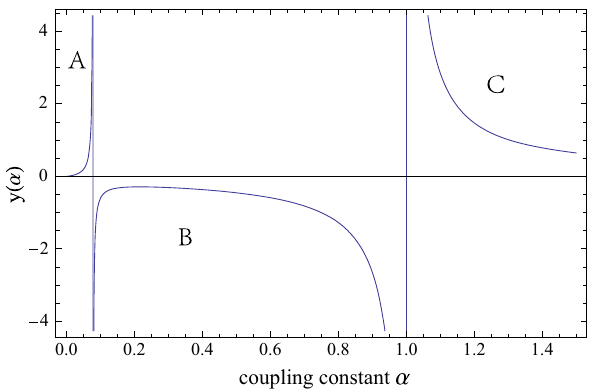
E Fig. 3 The horizontal axis represents the coupling constant α an , the verticalaxisrepresents y an (α an ) .RegionBhasnocorresponding y an (μ) , and it should not be taken into consideration